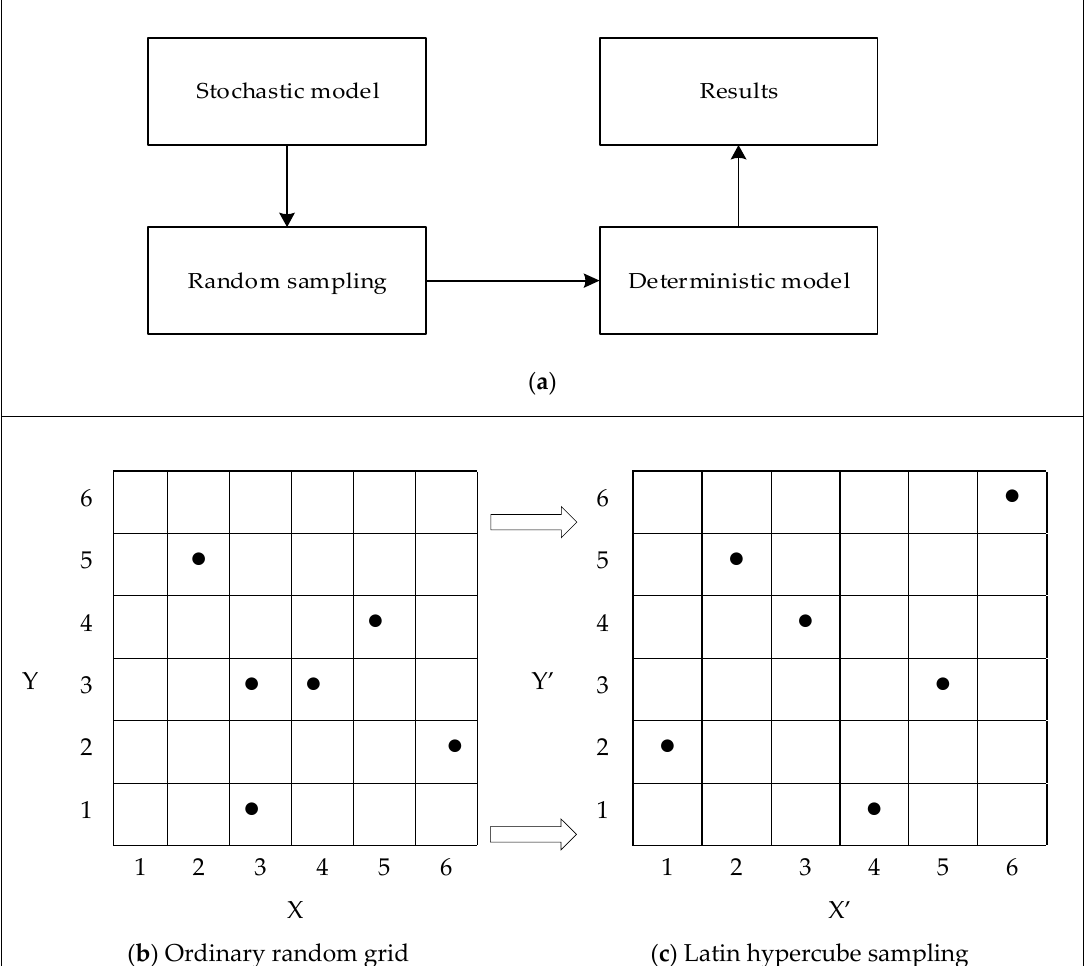
Figure 5. ( a ) exemplification of the Monte Carlo algorithm; ( b ) and ( c ) transformation from the ordinary random grid to a Latin